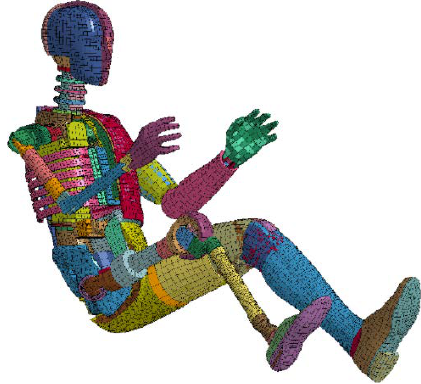
Fig. 4 Improved dynamics model